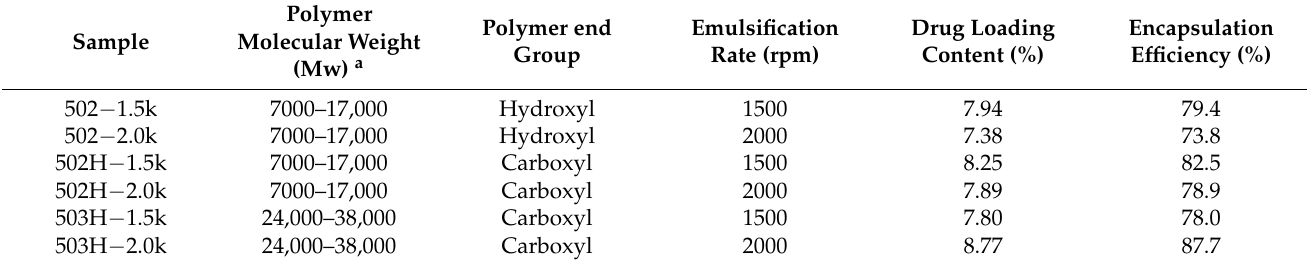
Table 1. Rivoceranib microsphere formulations.